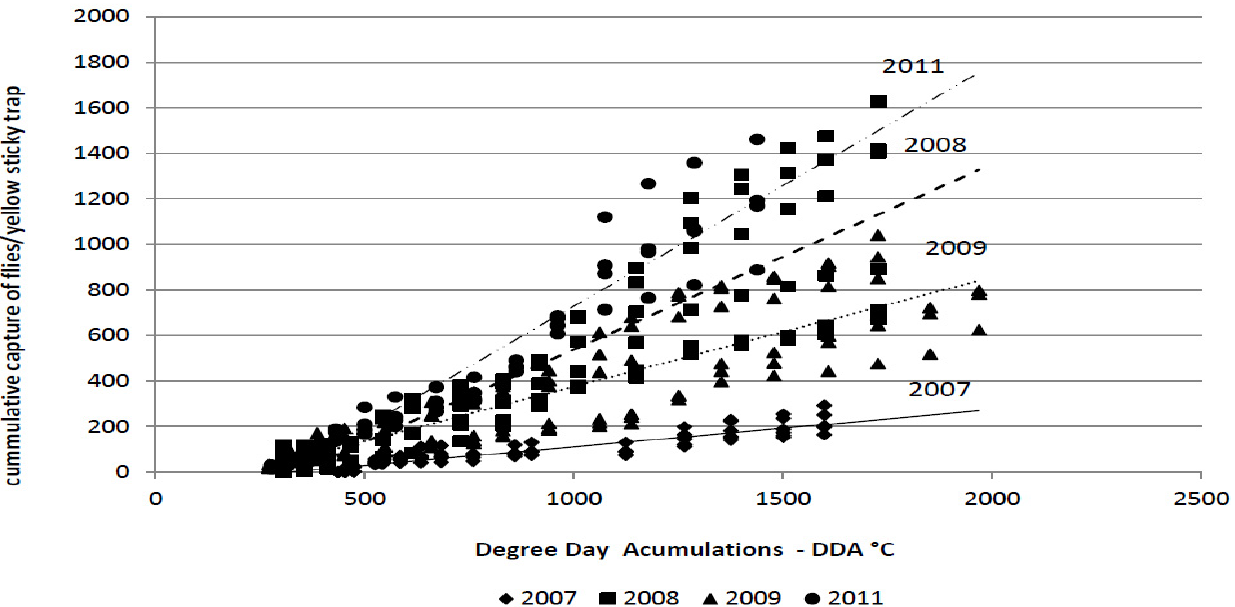
Figure 2. Linear regression analysis of the degree-day accumulations (base threshold 4.3 °C) vs. the cumulative capture of the cabbage maggot adults ( Delia radicum (L.)) on yellow sticky traps over four field seasons (2007 to 2009, 2011).